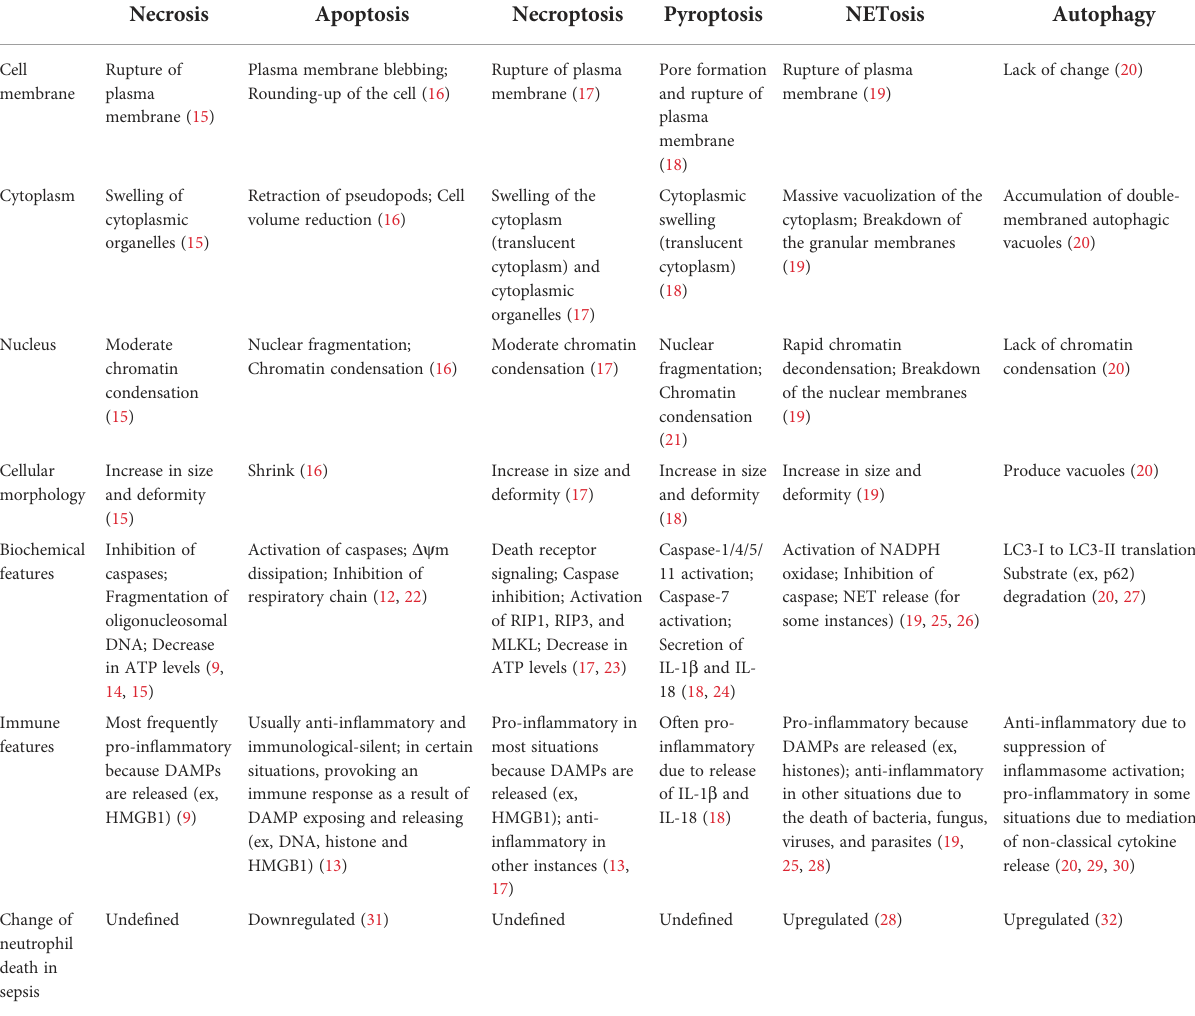
TABLE 1 Comparison of features in different types of cell